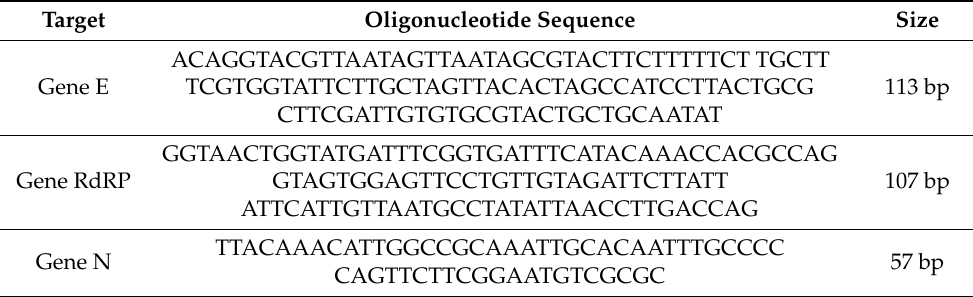
Table 1. Sequences of SARS-CoV-2 used as targets in RT-HDA